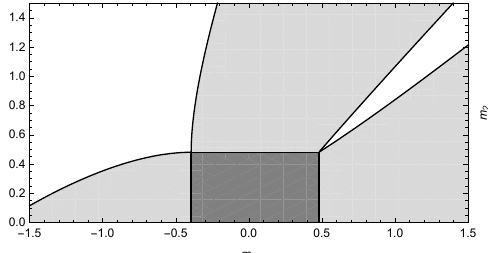
Figure 12 . Phase diagram in the half-plane { m 1 ∈ R , m 2 ≥ 0 } . The plot is at ( t, λ, ζ 1 , ζ 2 ) = (cid:0) 22 (cid:1) . In the darker shaded region both singularities lie in the support of the eigenvalue , − 10 , 1 , 6 3 5 density. In the lighter shaded regions one singularity lies inside and the other lies outside the support. In the white region none of the singularities lies inside the